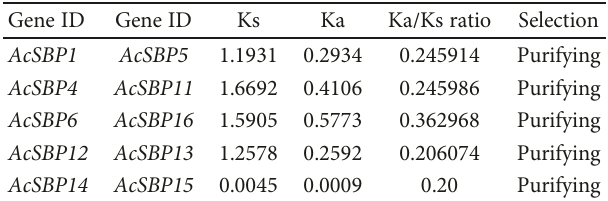
Table 2: Ka/Ks ratios of SBP